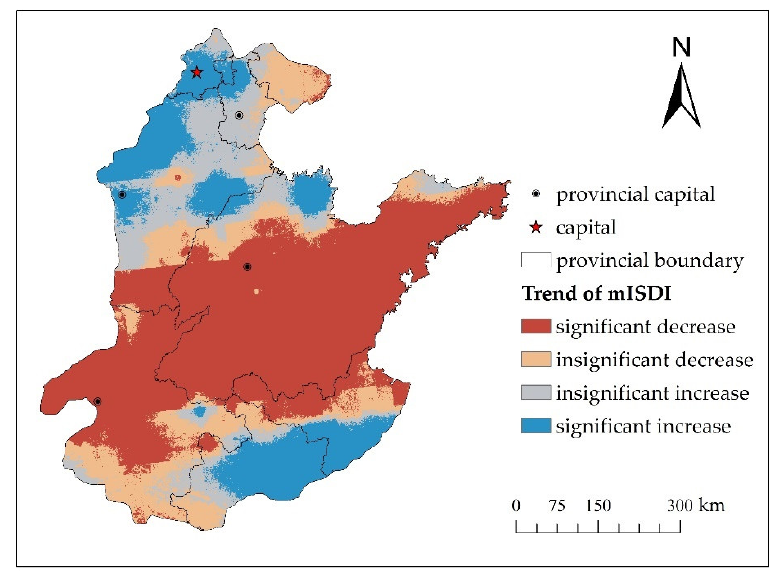
Figure 7. Spatial variation trend of the mISDI in the HHHP.